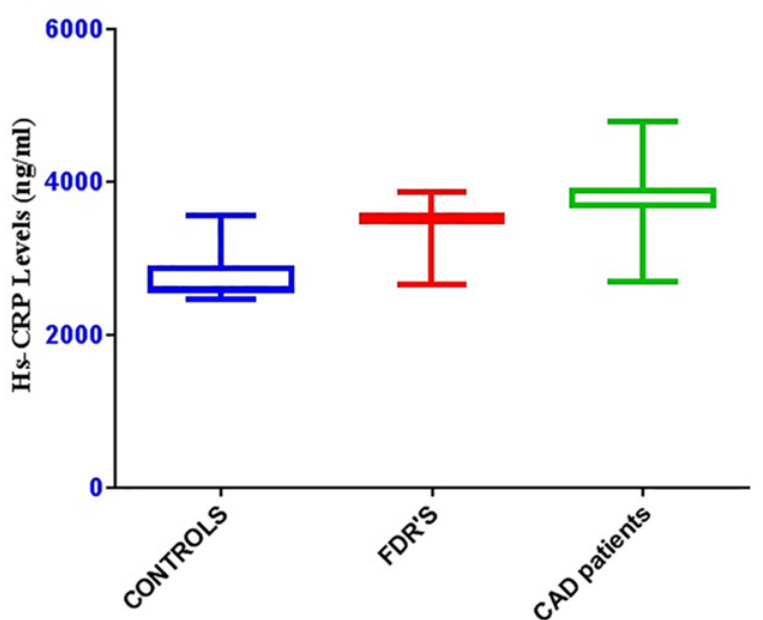
Fig 1. Analysis of Hs-CRP levels (ng/ml) in Coronary Artery Disease (CAD) patients, FDRS and Controls.